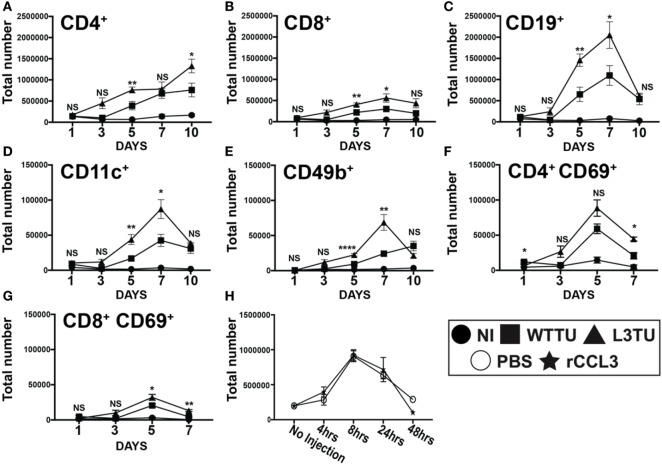
Autologous tumor-derived CCL3 (aCCL3) expression augments T cell activation by enhancing leukocyte migration to the tumor-draining lymph nodes (TDLNs). (A–E) Cellular accumulations of specific immune subtypes in the TDLN are shown over the course of 10 days following tumor inoculation. (F,G) Upregulation of the early activation marker, CD69, on T cells over the first 7 days following tumor inoculation. (H) Total cellularity changes in the popliteal lymph node of naive mice in the first 48 h following a footpad injection of recombinant CCL3 (rCCL3; 100 ng/mouse). For (A–G), n = 3–7 mice for each day. Experiments were repeated two to three times for each data point. H represents two biological repeats with n = 2 mice in each time point. Not significant (ns), p > 0.05; *p = 0.01–0.05; **p = 0.001–0.01; ***p = 0.0001–0.001; ****p < 0.0001.